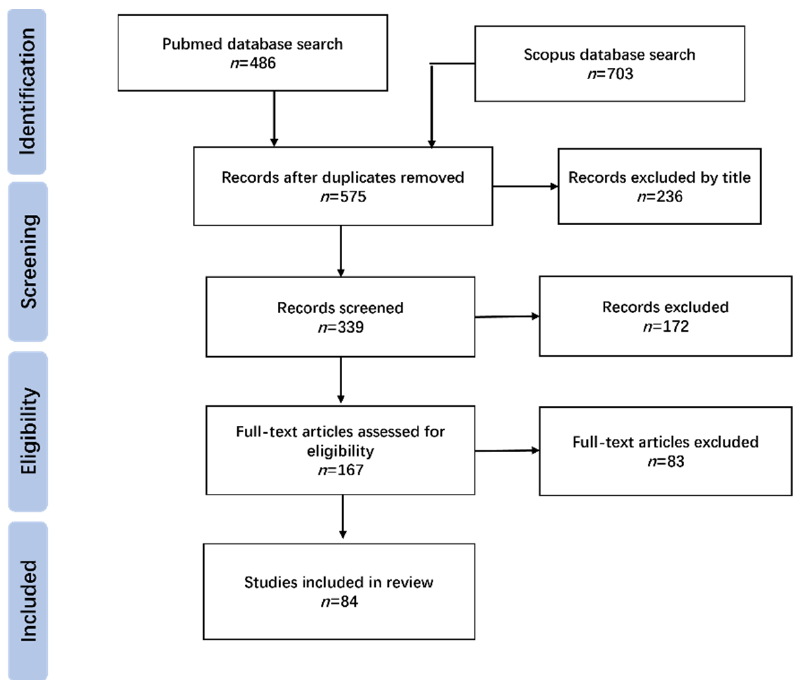
Figure 1. Flow diagram of literatures review.